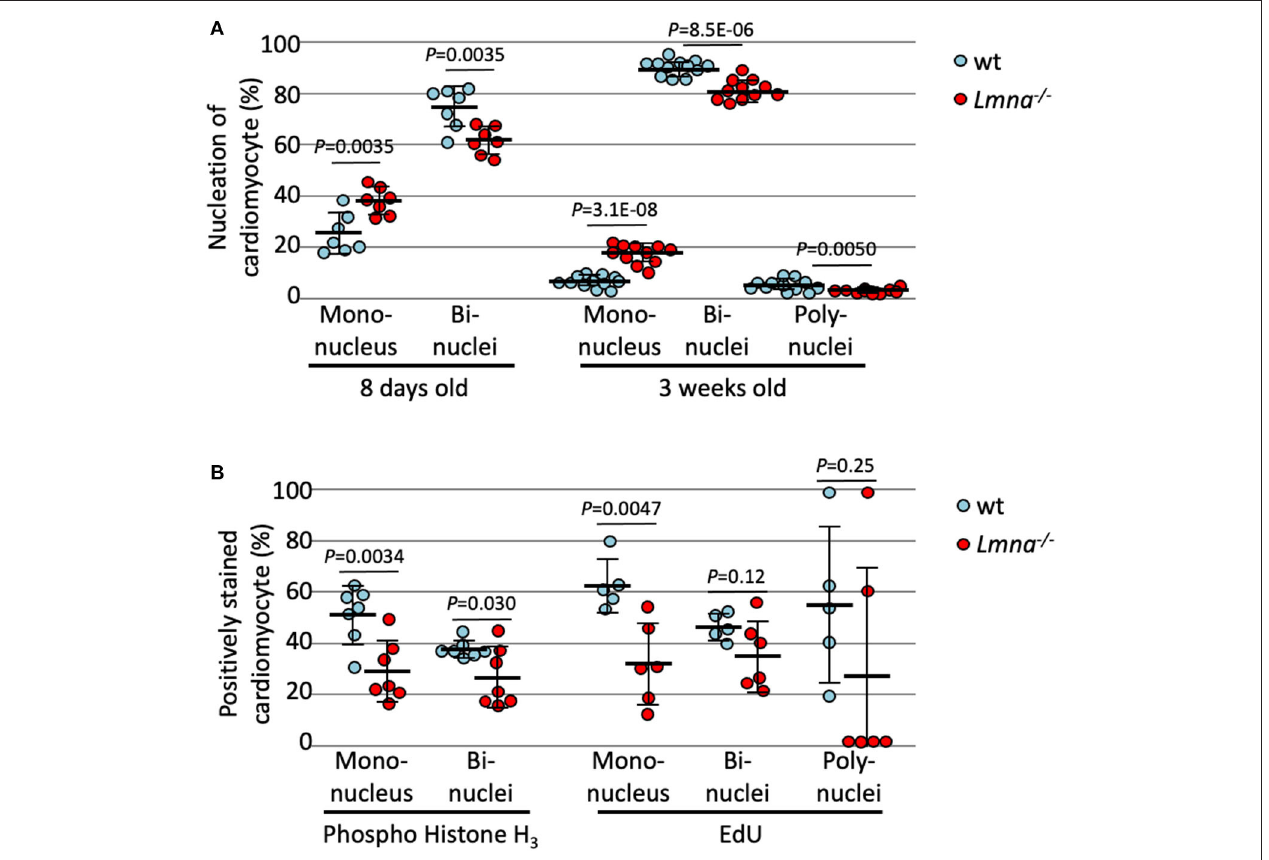
FIGURE 2 | Nucleation and cell cycle markers of cardiomyocytes in wild type (wt) and Lmna − / − mice. (A) Nucleation of cardiomyocytes in 8 days old ( n = 7 in each group) and 3 weeks old ( n = 12 in wt and 11 in Lmna − / − ) showed more mononuclear and less bi- or poly-nuclear cardiomyocytes in Lmna − / − mice. (B) Percentage of phospho-histone H 3 positive cardiomyocytes in 8 days old ( n = 7 in each group) and of EdU positive cells in 3 weeks old ( n = 5 in wt and 6 in Lmna − / − ) showed retarded cell cycle in Lmna − / − mice. Dots represent individual mouse data. The significance of differences between two groups was determined using the Student’s 2 tailed T